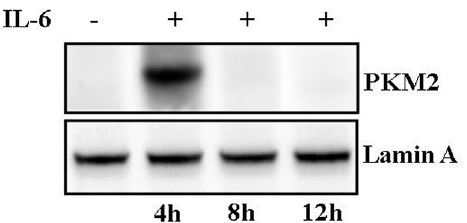
Figure 9. Analysis of PKM2 in nuclear extracts following IL-6 stimulation in a time course experiment on LNCaP cells. Western blot analysis of PKM2 in LNCaP cells, untreated and treated for 4, 8, and 12 h with IL-6. Lamin A was used as specific nuclear marker and normalization protein.